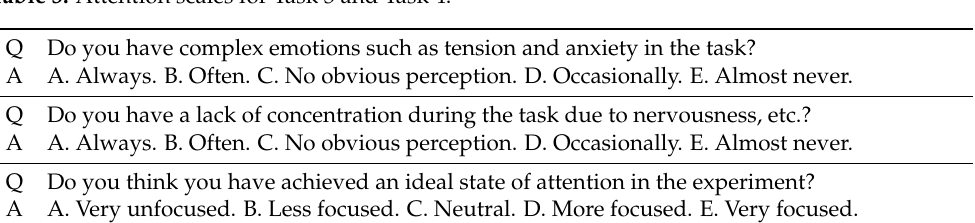
Table 3. Attention scales for Task 3 and Task